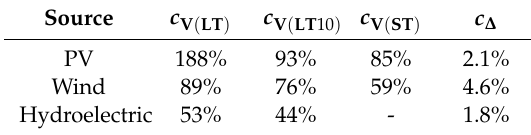
Table 5. Coe ffi cients of variation for the analyzed